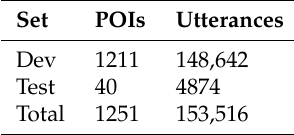
Table 3. Development and test set statistics of VoxCeleb1 for verification.